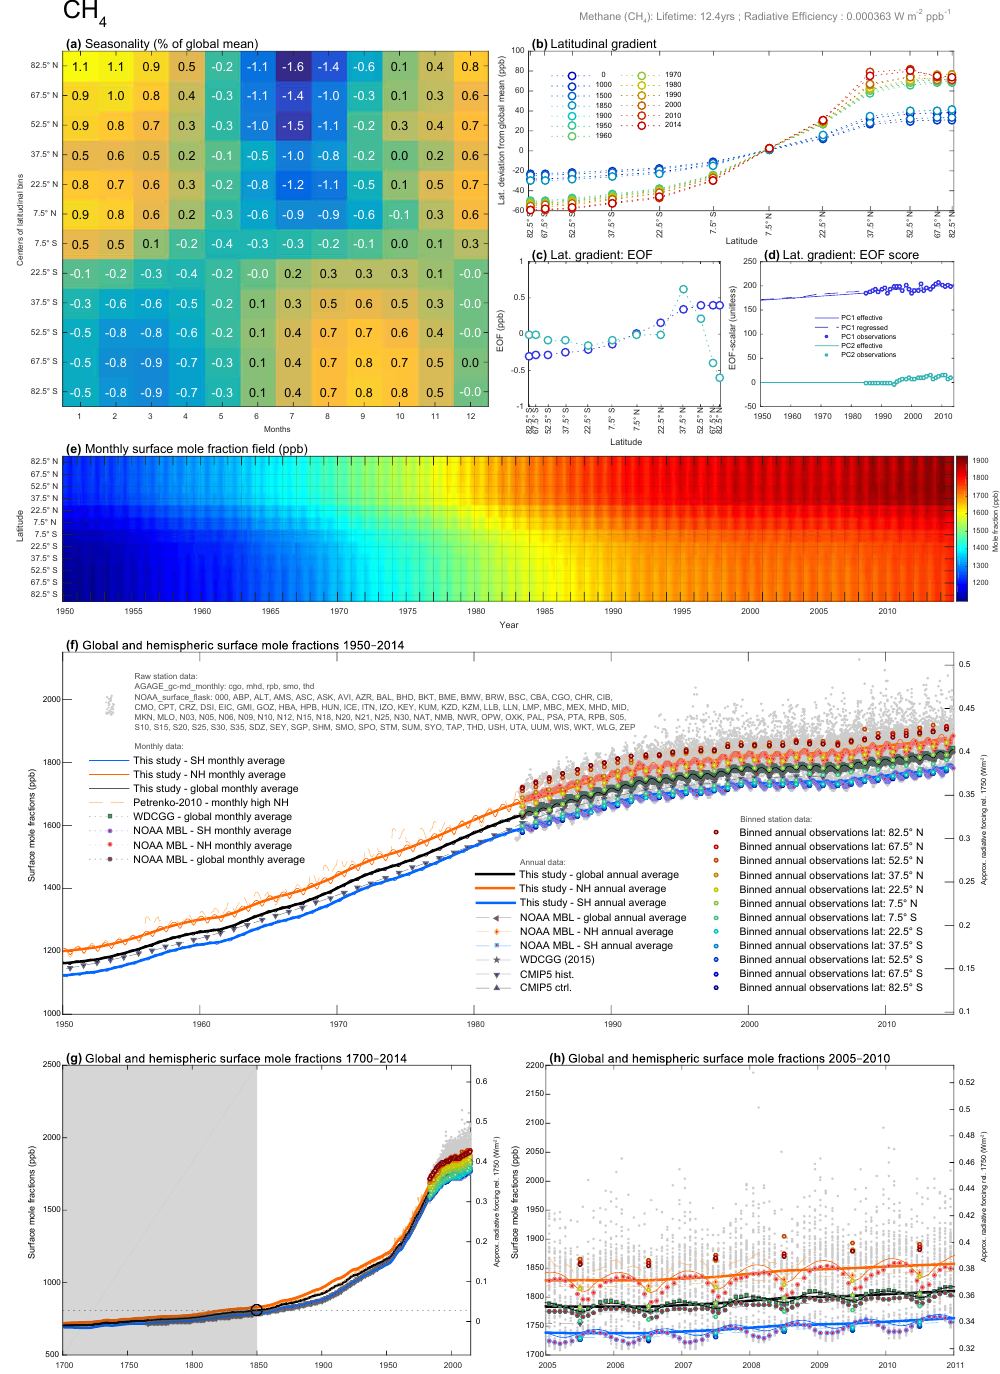
Figure 11. Overview of historical CH 4 concentrations. (a.1) The relative seasonality of CH 4 over the observational period. (b) The latitudinal variation of concentrations (dashed lines), shown for example years. (c) The first and second EOF of latitudinal variation. (d) The EOF scores derived from the observational data (dots) and regression against global emissions (dashed line) as well as the ultimately used EOF score (solid line). (e) The resulting latitudinal-monthly concentration field, here shown between 1950 and 2014. (f) Global and hemispheric means of the derived concentration field over the same time period 1950–2014 in comparison to monthly station data (grey dots), latitudinal average station data (coloured circles), and various literature studies (see legend). (g) Same as (f) , except for time period 1750–2014. (h) Same as (f) but for time period